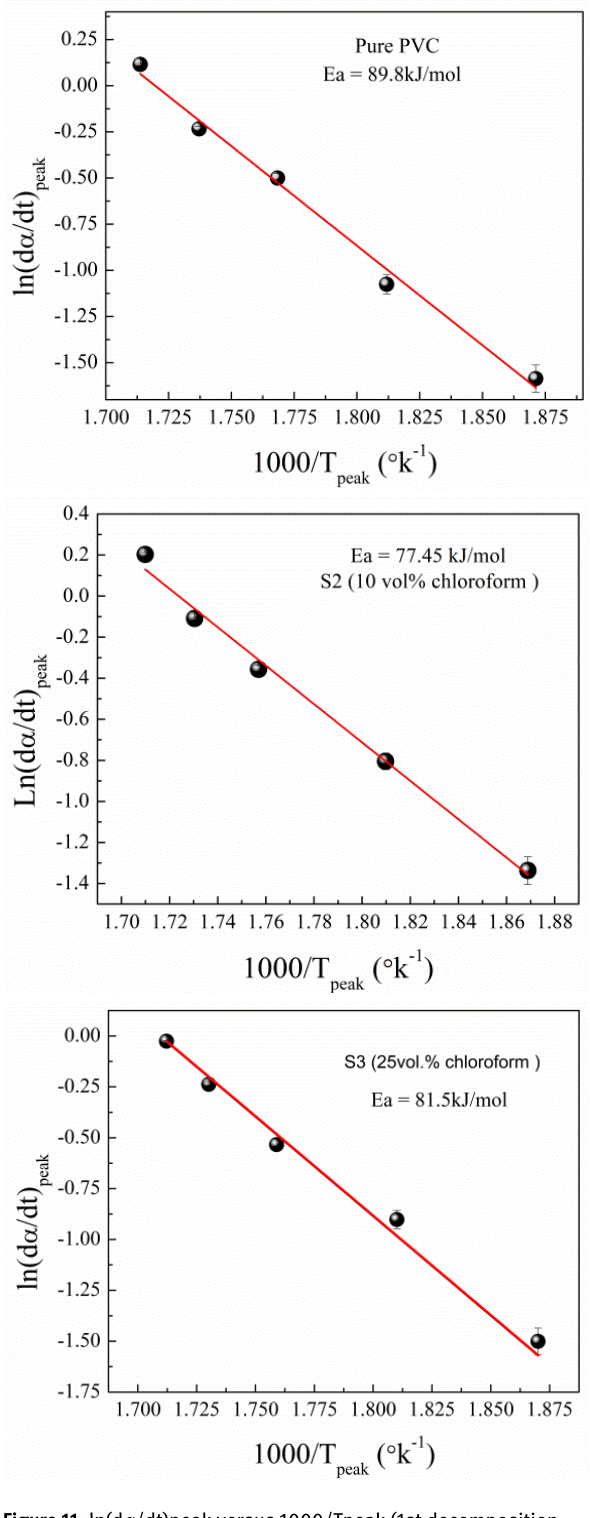
Figure 11: ln(d α /dt)peak versus 1000/Tpeak (1st decomposition stage) for PVC and PVC/MWCNTs nanocomposite samples